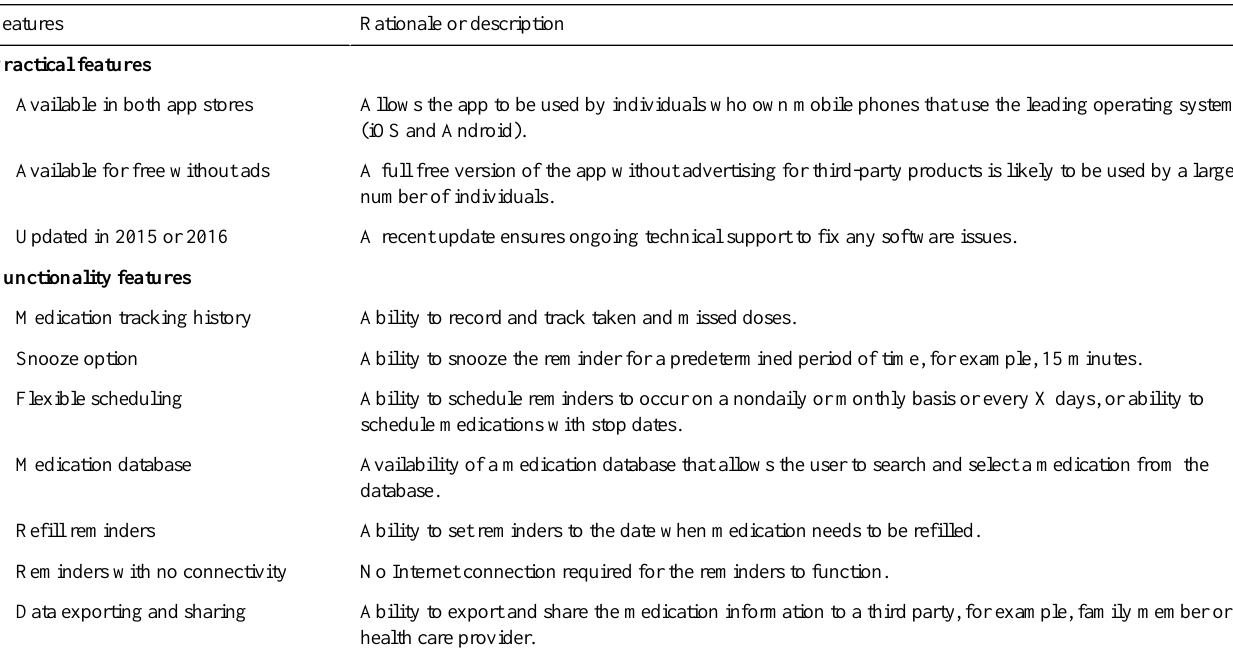
Table 1. Practical and functionality features’description. Practical